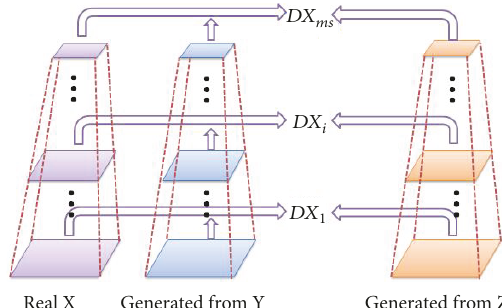
Figure 2: The example of multiscale and multilevel discriminator. There are three columns, which, respectively, represent the real samples 𝑋 domain, generated samples from 𝑌 domain by F1, and generated samples from 𝑍 domain by G3. 𝐷 𝑋𝑖 represents multiscale and multilevel discriminator, 𝑖 ∈ [1,𝑚𝑠]